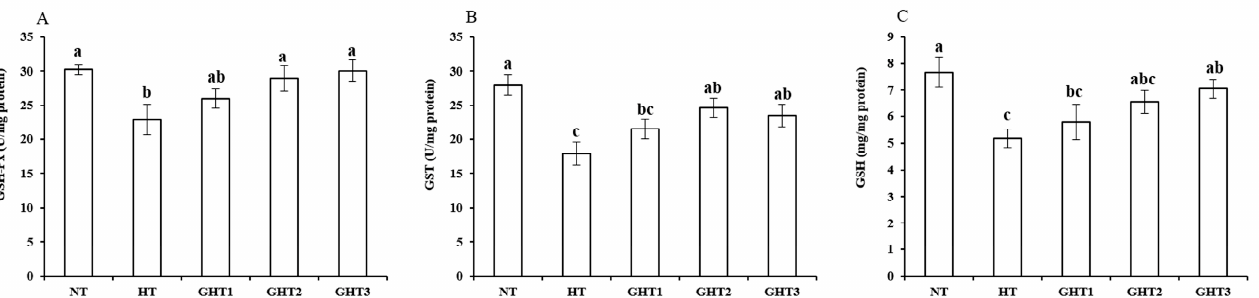
Figure 4. Effect of Gln on GSH-Px ( A ), GST ( B ), and GSH ( C ) levels on the livers of broilers exposed to high temperature conditions. Different lowercase letters above each column indicate significant ( p < 0.05) differences among the groups. NT group: Broilers were kept in a normal temperature environment and fed a basal diet. HT, GHT1, GHT2, and GHT3 groups: Broilers in these groups were kept in high temperature conditions and fed a basal diet supplemented with 0%, 0.5%, 1.0%, and 1.5% Gln.